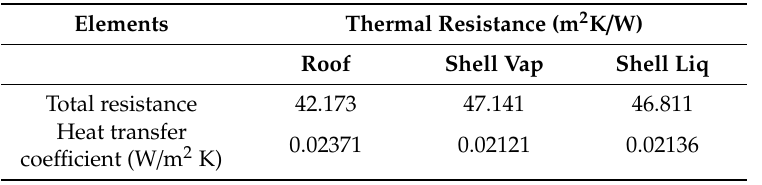
Table 5. Total thermal resistance and heat transfer coefficient value needed for heat leak calculations obtained using the values given in Tables 1–4.